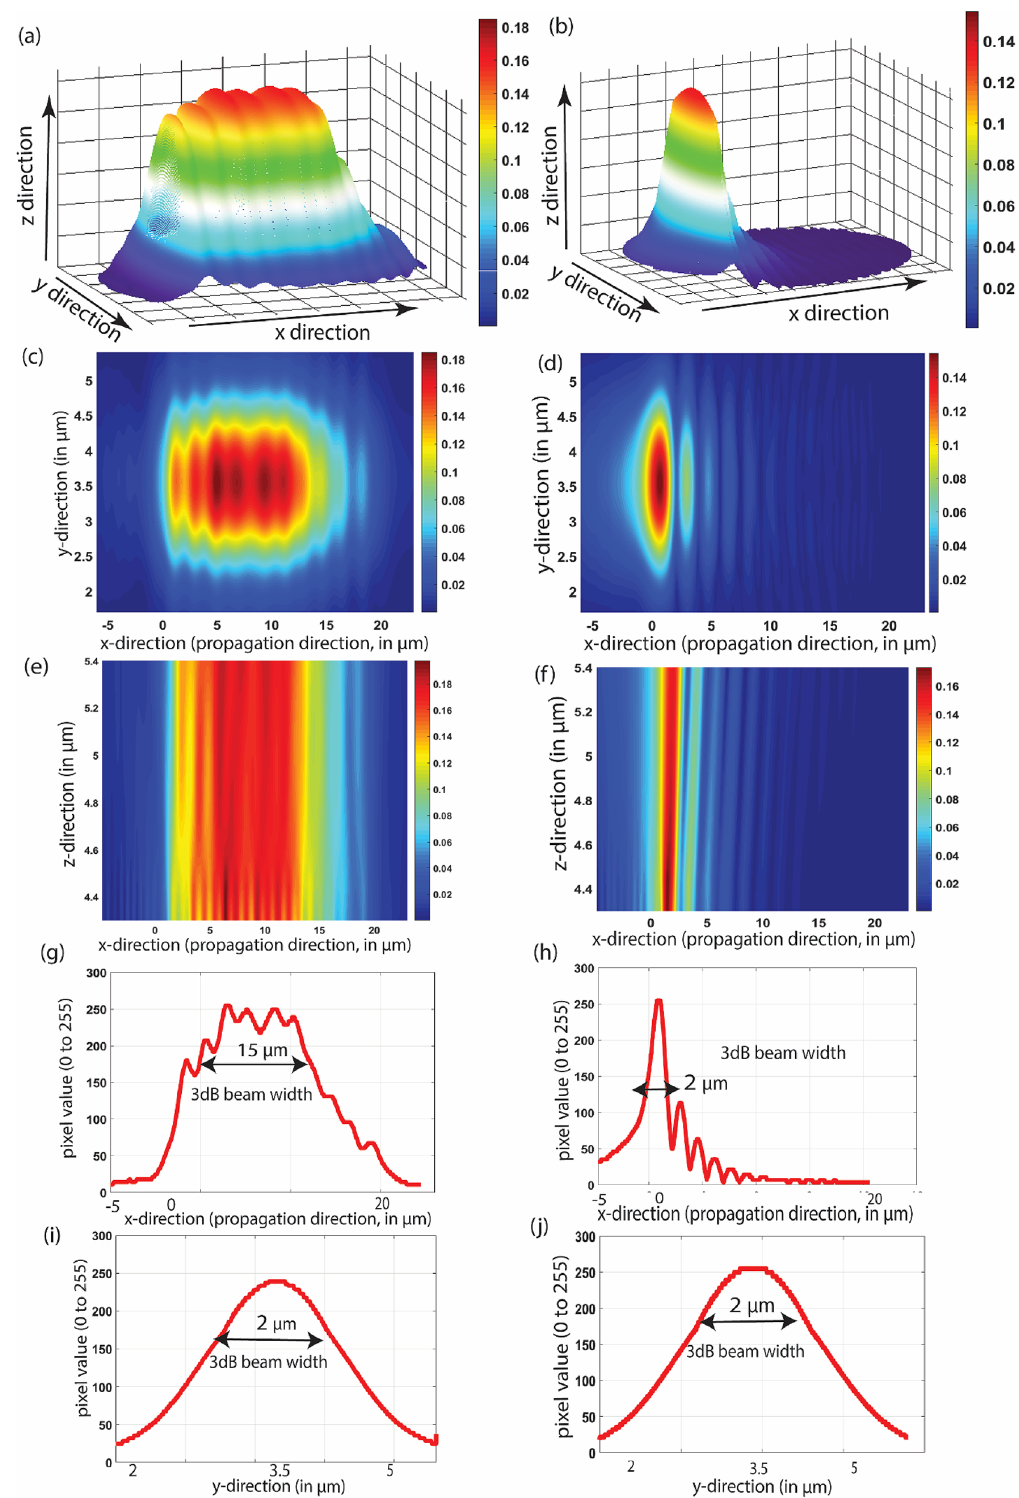
Figure 6. Diffraction beam profile from the meta surface and the conventional binary grating structure. ( a , b ) The 3D beam profiles. ( c , d ) The top view of the beam profile from the meta surface and conventional gratings respectively. ( e , f ) Side view of the beam profile from the metasurface and conventional gratings respectively. ( g , h ) The 3 dB beam width analysis in the x direction for the metasurface and conventional gratings respectively. ( i , j ) The 3 dB beam width analysis in the y direction for the metasurface and conventional gratings respectively. Figure created in